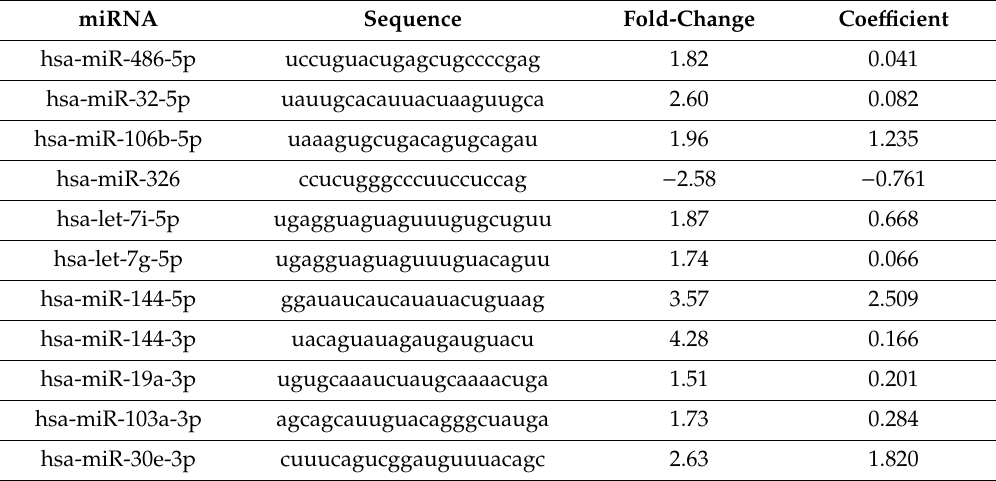
Table 2. miRNAs comprised in the predictive model of VTE in PDAC and DECC patients obtained in the screening stage. miRNA sequences according to miRBase 22.1. Fold-change is defined as the ratio of the average expression level of a miR in PDAC and DECC patients who su ff ered a VTE event during follow-up and those who did not. miRNA Sequence Fold-Change Coe ffi